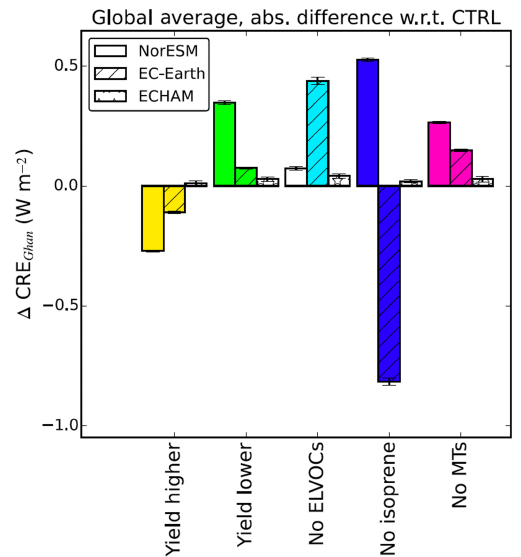
Figure 7. Bar plots of the global average cloud radiative effect (CRE Ghan ) between each sensitivity simulation and the CTRL simu- lations. Coloured bars indicate a significant difference in the simula- tion averages with a 95% confidence interval. The error bars denote the standard error of mean of the yearly